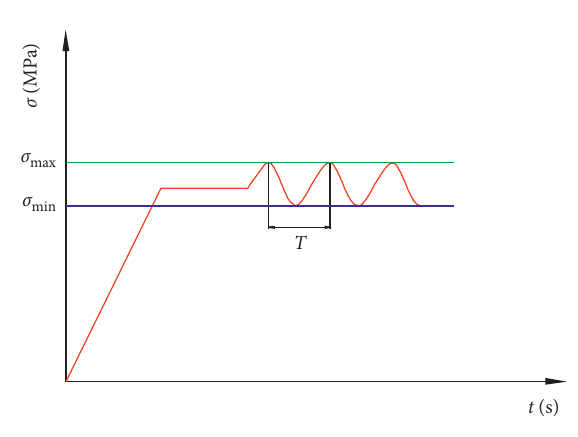
Figure 3: Loading